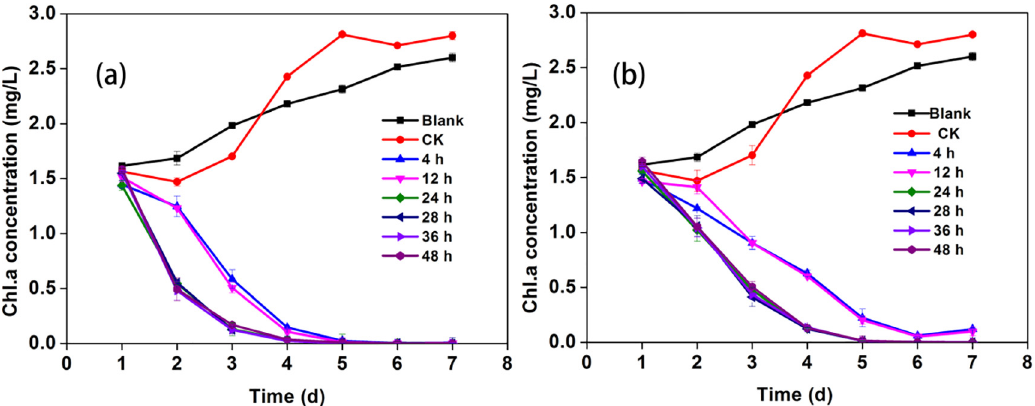
Figure 5. The e ff ects of di ff erent age of bacterial strain on chlorophyll-a of Microcystis aeruginosa . ( a ) Figure 5. The effects of different age of bacterial strain on chlorophyll-a of Microcystis aeruginosa. ( a ) strain 39 # and ( b ) strain 91 # strain 39 # and ( b ) strain 91 # .